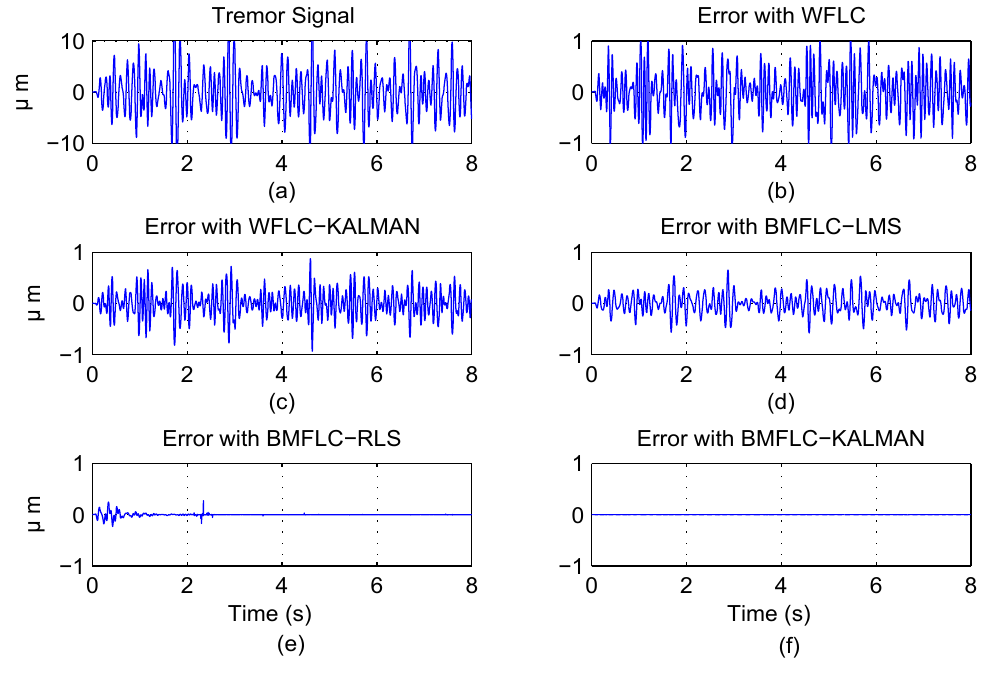
Figure 7. Performance of all algorithms with Surgeon #1 (pointing task).